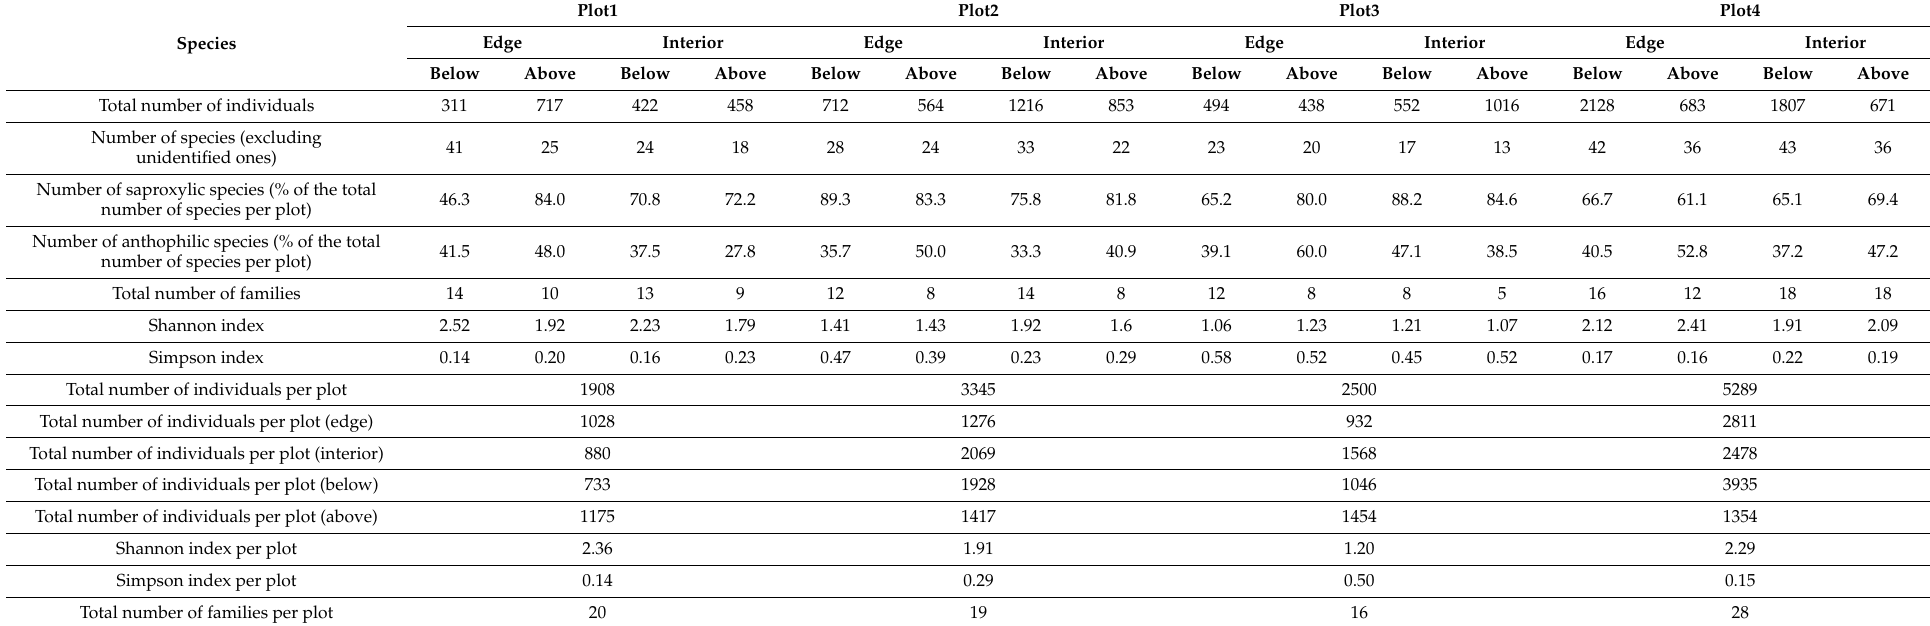
Table 1. The main indicators of the number and species diversity of Coleoptera collected using beer traps on the edges and in the forest interior. Plot1 Plot2 Plot3 Plot4 Edge Interior Edge Interior Edge Interior Edge Interior Species Below Above Below Above Below Above Below Above Below Above Below Above Below Above Below Above Total number of individuals